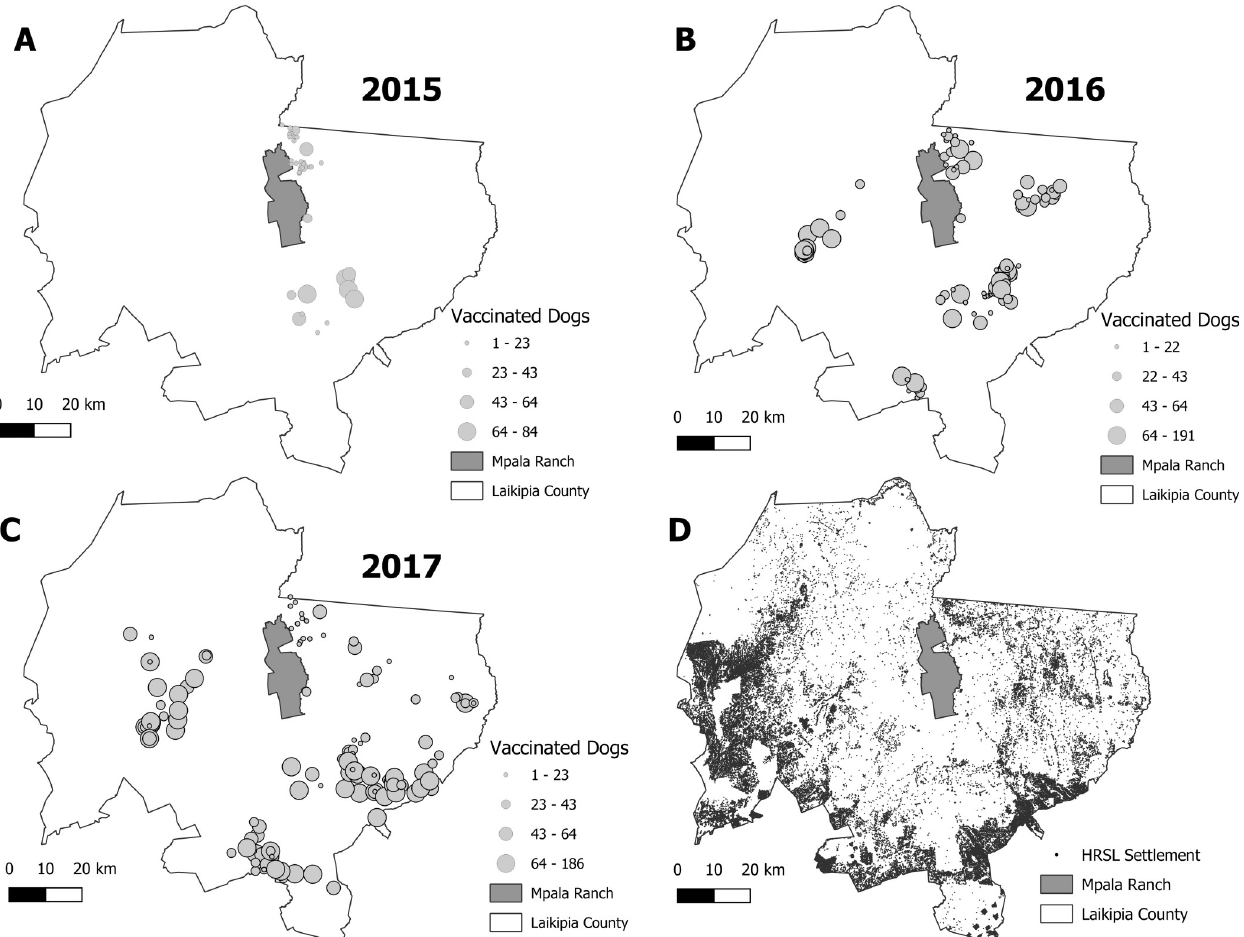
Fig 2. Total number of dogs vaccinated at central point vaccination stations. Central point vaccination stations depicting total number of dogs vaccinated per station for (A) 2015, (B) 2016, and (C) 2017. (D) Depiction of settlements using the High Resolution Settlement Layer (HRSL) for Laikipia County, Kenya. Maps were generated using QGIS 2.18.11 Geographic Information System from the Open Source Geospatial Foundation Project http://qgis.osgeo.org with layers sourced from original GPS coordinates in the field (e.g., number of dogs vaccinated/station), the World Agroforestry Centre’s Geoscience